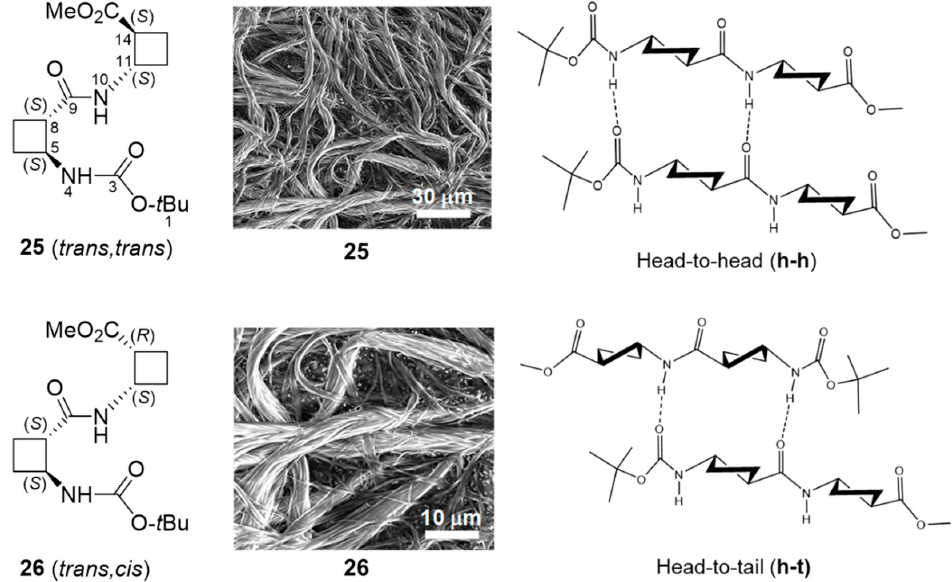
Figure 19. Chemical structures of dimeric CBAA derivatives 25 and 26 ( left ), SEM images of samples of 25 and 26 as xerogels from toluene ( center ) and the possible arrangement of two molecules of 25 interacting through two intermolecular hydrogen bonds ( right ). Adapted with permission from Wiley [49].